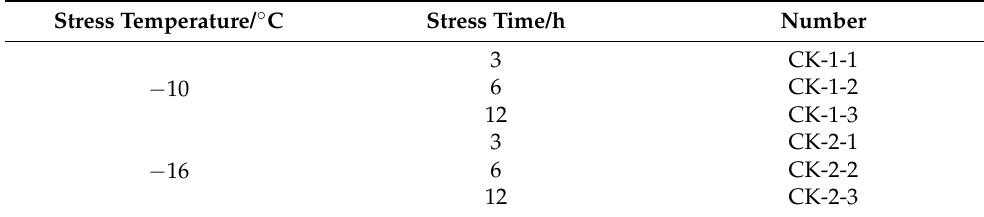
Table 2. The numbers of the transcriptome sequencing samples. Stress Temperature/ ◦